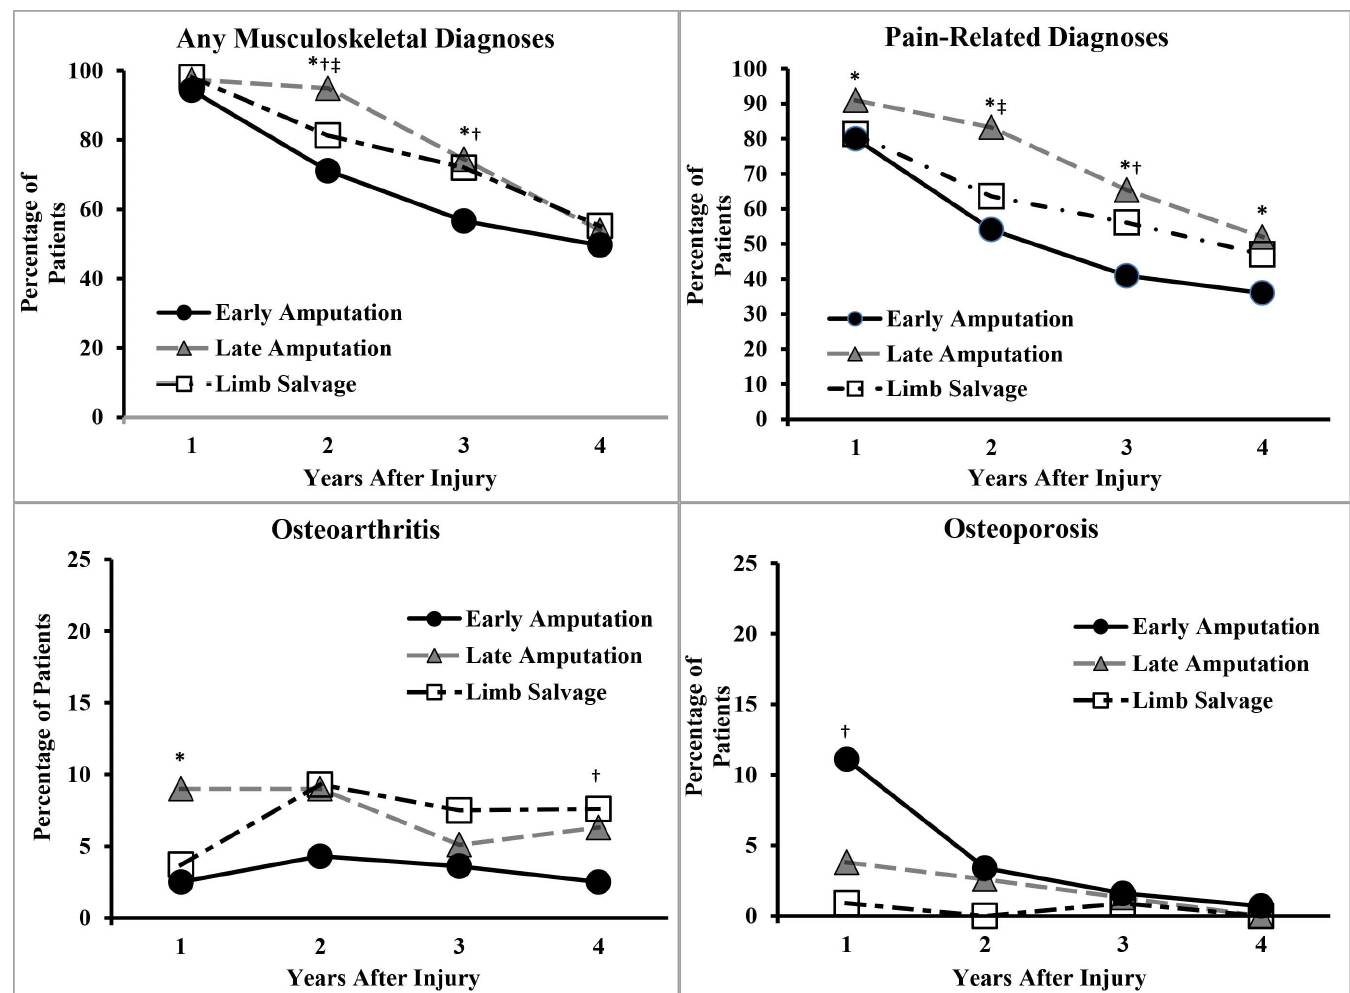
Fig 2. Prevalence of Selected Physical Health Complications by Time After Injury. Statistically significantdifference between groups, using chi-square or Fisher’s exact test as appropriate, p < 0.05 were * early amputation versus late amputation, †early amputation versus limb salvage,and ‡late amputation versus limb salvage.(Table 3 shows where injury group was significantly associated with outcomes after adjustingfor covariates).